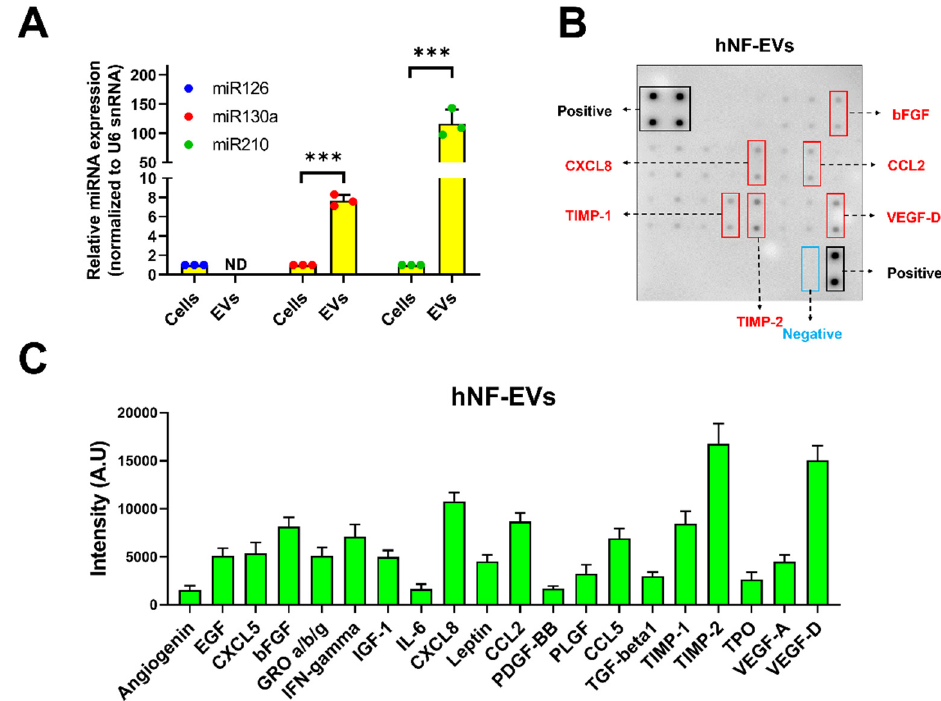
Figure 3. Identification of proangiogenic miRNAs and proteins in hNF-EVs. ( A ) Real-time PCR anal- ysis for miR-126, miR-130a, and miR-210 expression in hNF cells or hNF-EVs ( n = 3), normalized with U6 snRNA. Mean ± SD are derived from the minimum of three values from individual experiments. ( B ) A representative array blot incubated with hNF-EVs lysate (200 µ g/blot). ( C ) Bar graph of the quantitative results (intensity) of the spots of each protein ( n = 4). *** p < 0.001. A student’s t -test was used for comparison.